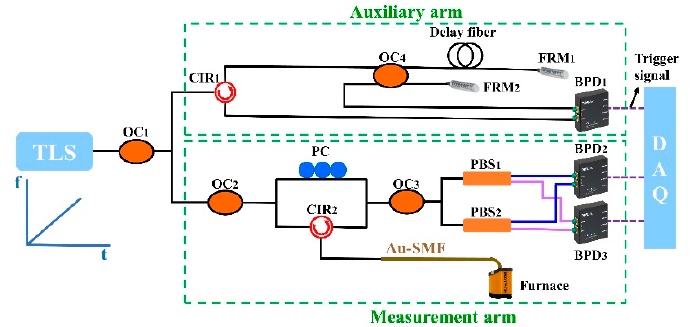
Figure 1. Optical frequency domain reflectometry (OFDR) experimental setup for distributed temperature sensing (DTS) using an Au-coated single mode fiber (Au-SMF), consisting of an auxiliary arm and measurement arm. TLS: tunable laser source; OC: optical fiber coupler; CIR: circulator; FRM: Faraday rotating mirror; BPD: balanced photodetector; PC: polarization controller; PBS: polarization beam splitter; Au-SMF: Au-coated single mode fiber; DAQ: data